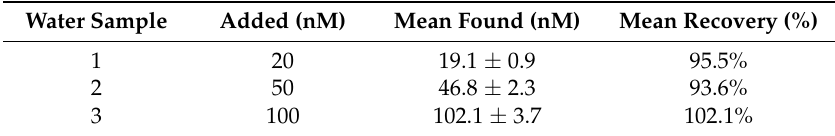
Table 3. Detection of CH 3 Hg + in real water samples (n = 3).